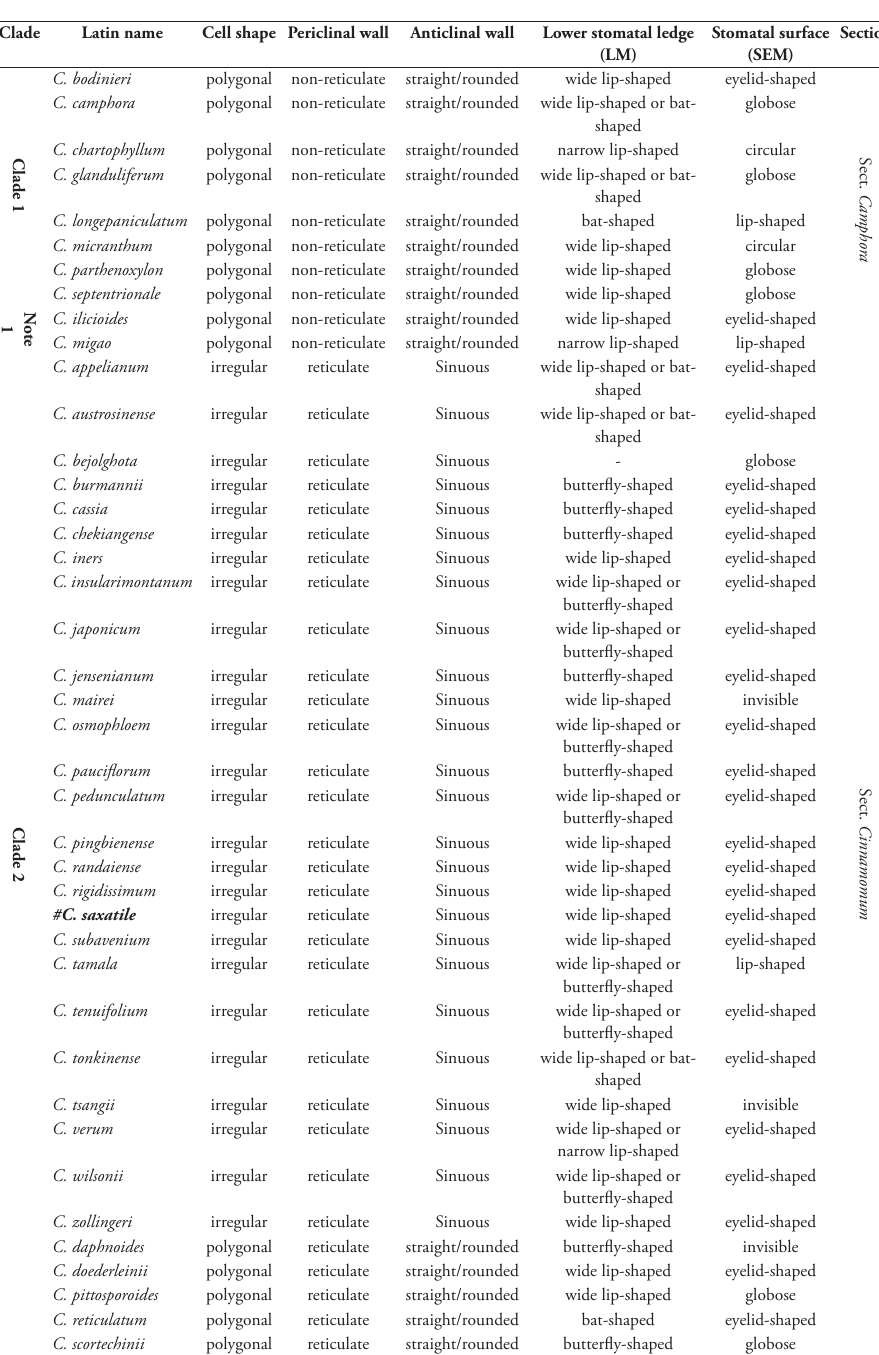
Table 3. Micromorphology of the leaf epidermis of Asian Cinnamomum under light microscopy (LM) and scanning electron microscope